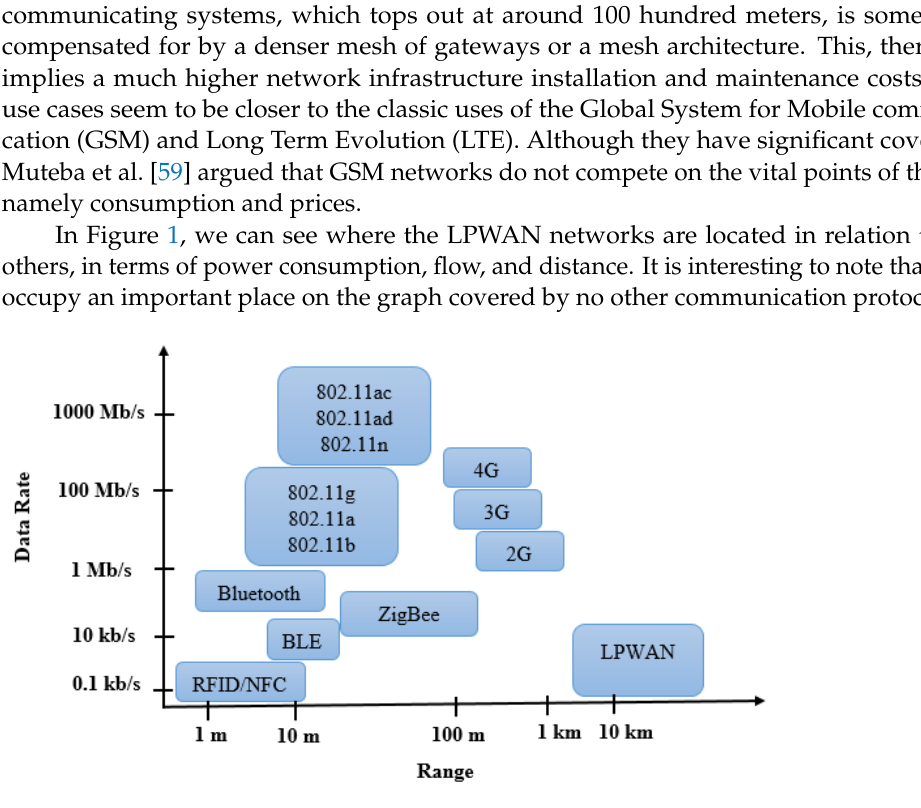
Figure 1. Data Rate vs. Range: LPWAN Positioning.